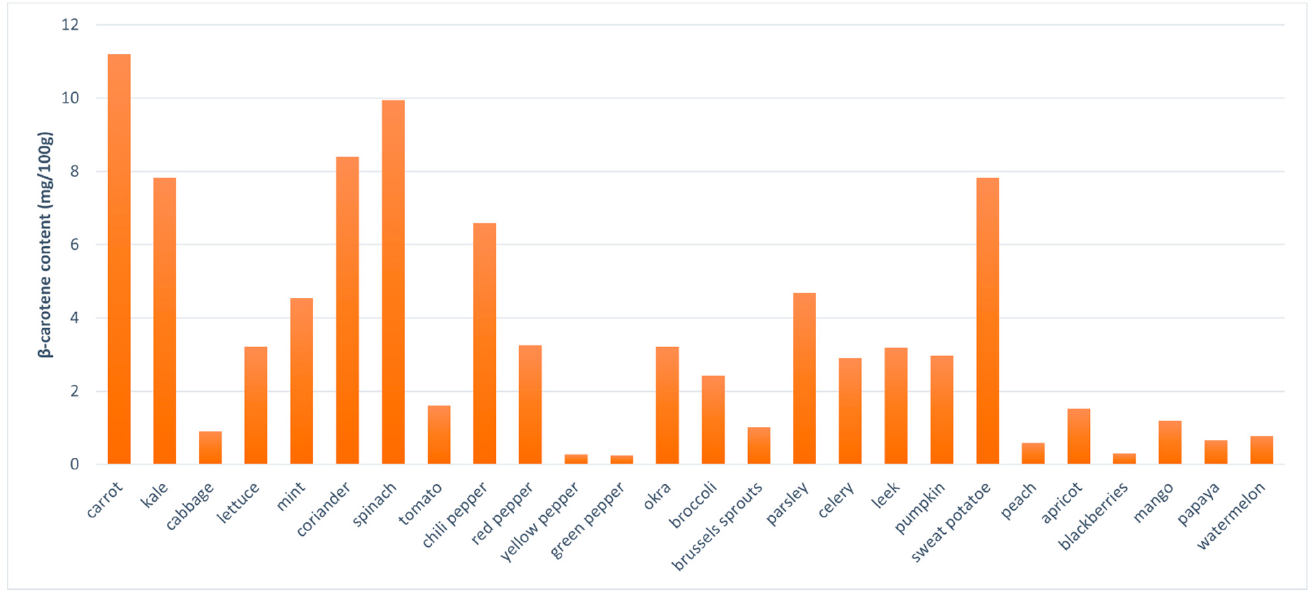
Figure 2. Selected plant sources of β -carotene [51–53].